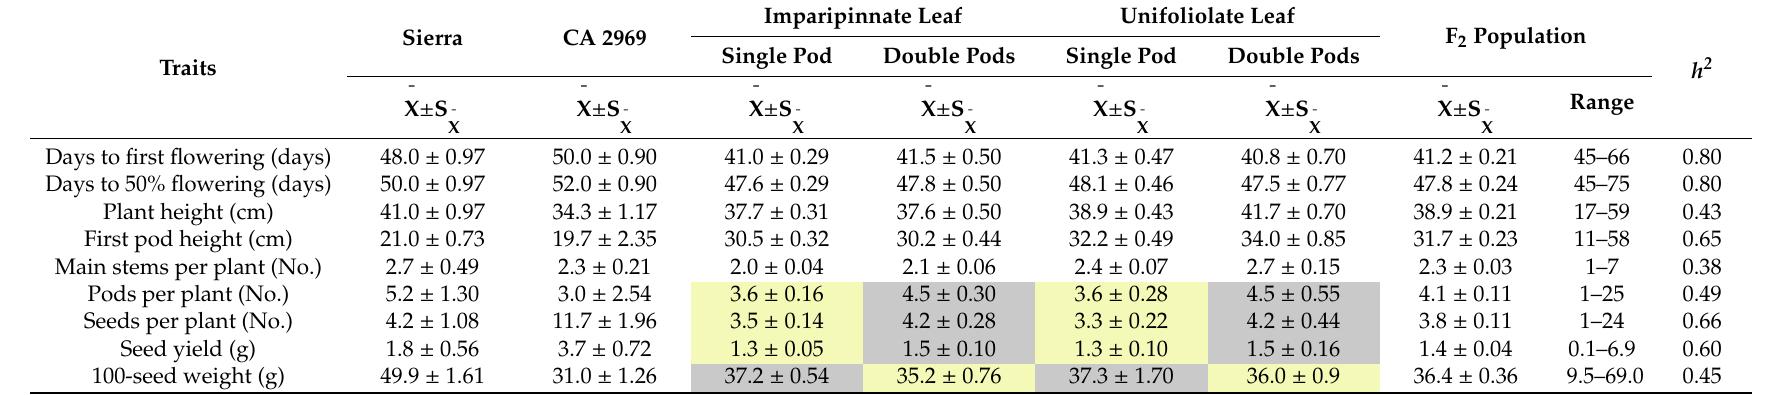
Table 2. Means ± standard errors, ranges and narrow sense heritability for agro-morphological traits in F 2 derived from intraspecific crosses between Sierra (single-podded and unifoliolate leaf) and CA 2969 (double-podded and imparipinnate leaf).